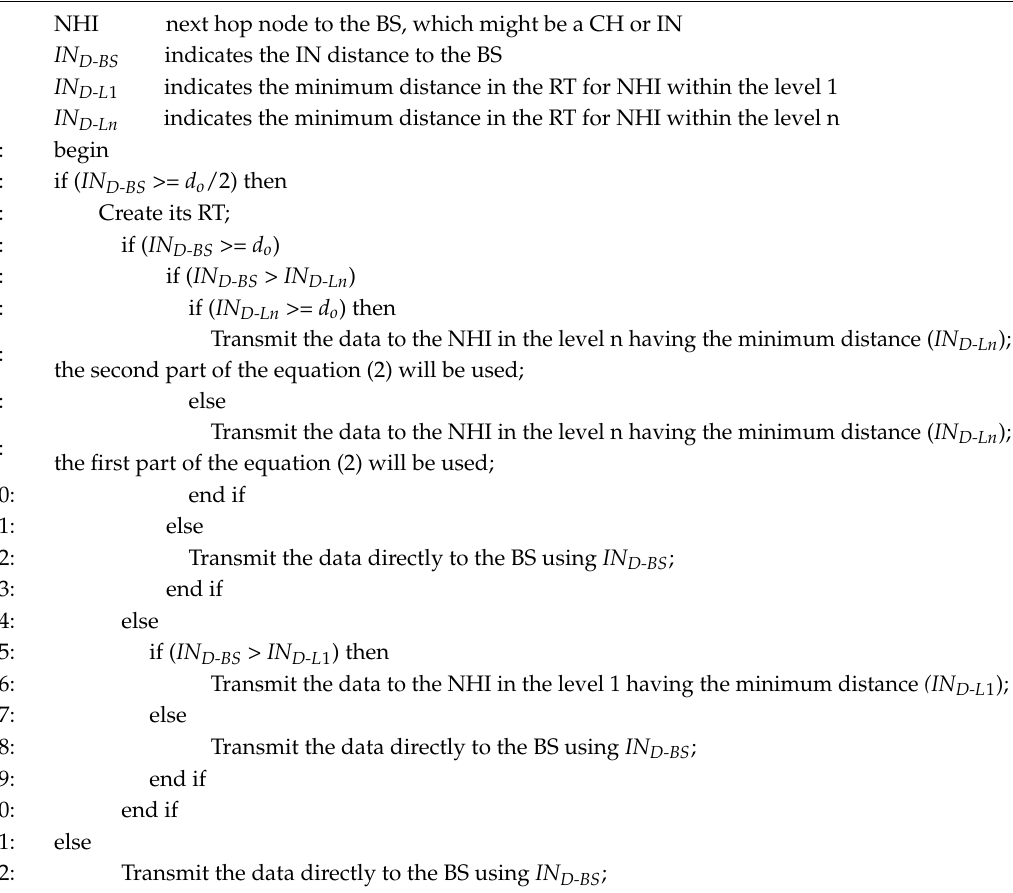
Algorithm 4: The inter-cluster routing for